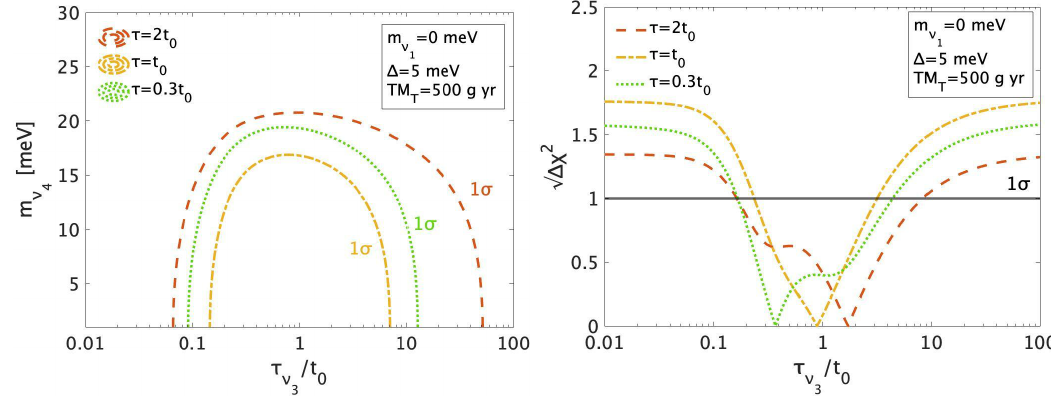
, m ) φ 3 0) (red 0 , = 500 g yr T